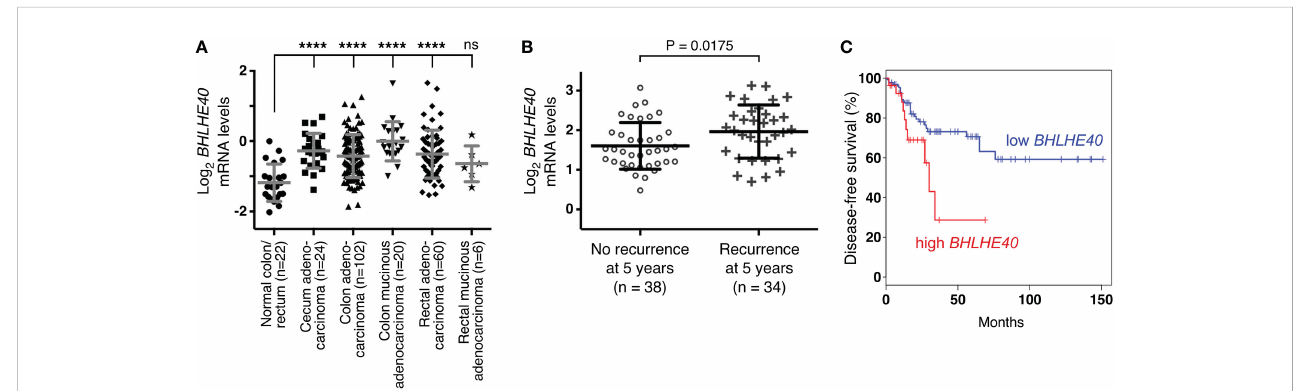
FIGURE 5 Expression of BHLHE40 in colorectal tumors. (A) BHLHE40 mRNA levels (reporter A_23_P57838; median-centered ratio) in TCGA microarray experiments (63). One-way ANOVA (Dunnett ’ s multiple comparisons test); ****P < 0.0001; ns, not signi fi cant. (B) Association of BHLHE40 mRNA levels with recurrence of colorectal carcinomas 5 years after diagnosis (data from reference (64); reporter 201169_s_at; median-centered ratio); unpaired, two- tailed t test. (C) Kaplan-Meier survival curve for patients with colorectal adenocarcinoma comparing high (90% cutoff, n=27) with low (50% cutoff, n=135) BHLHE40 mRNA expression. Analysis was done with GEPIA (http://gepia.cancer-pku.cn/index.html). P=0.028 (Logrank